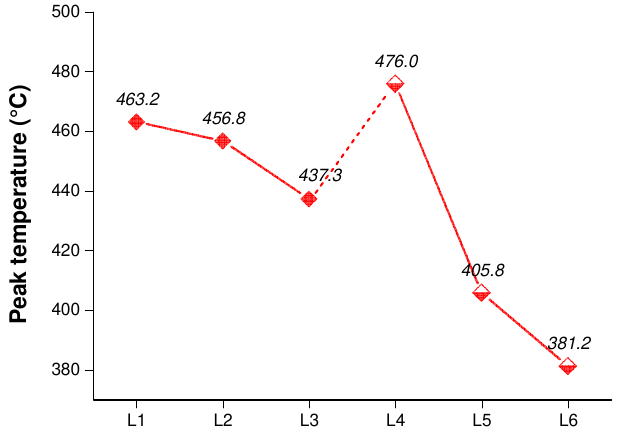
Figure 4. Peak temperatures from LDPE thermal degradation experiments with olefin additives (1-hexene, 1-octene or 1-decene) conducted under an initial atmospheric pressure and high-pressure (21 bar) conditions, respectively, all in a nitrogen atmosphere, at switch II and a set temperature of 380 °C.